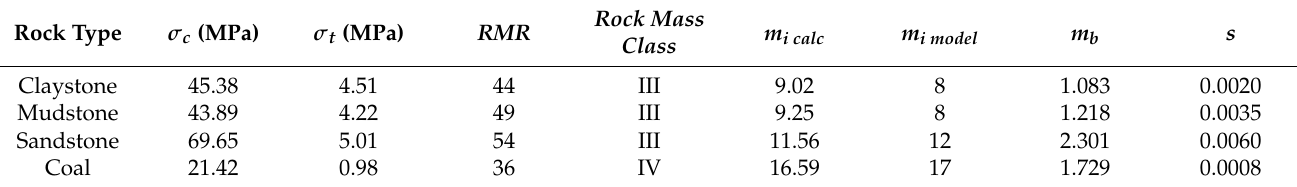
Table 2. Parameters of rocks from around roadway D-2.